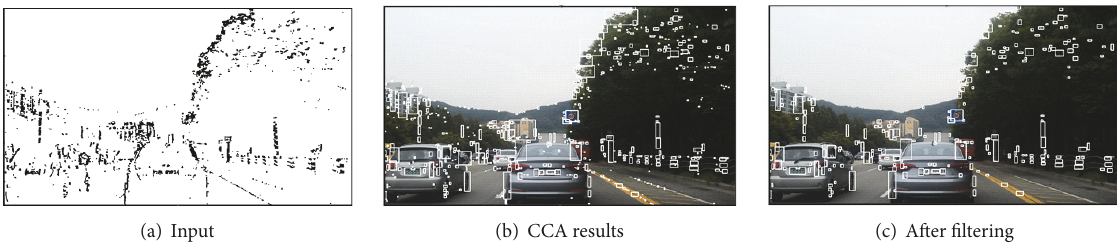
Figure 4: Detection of character areas by CCA and